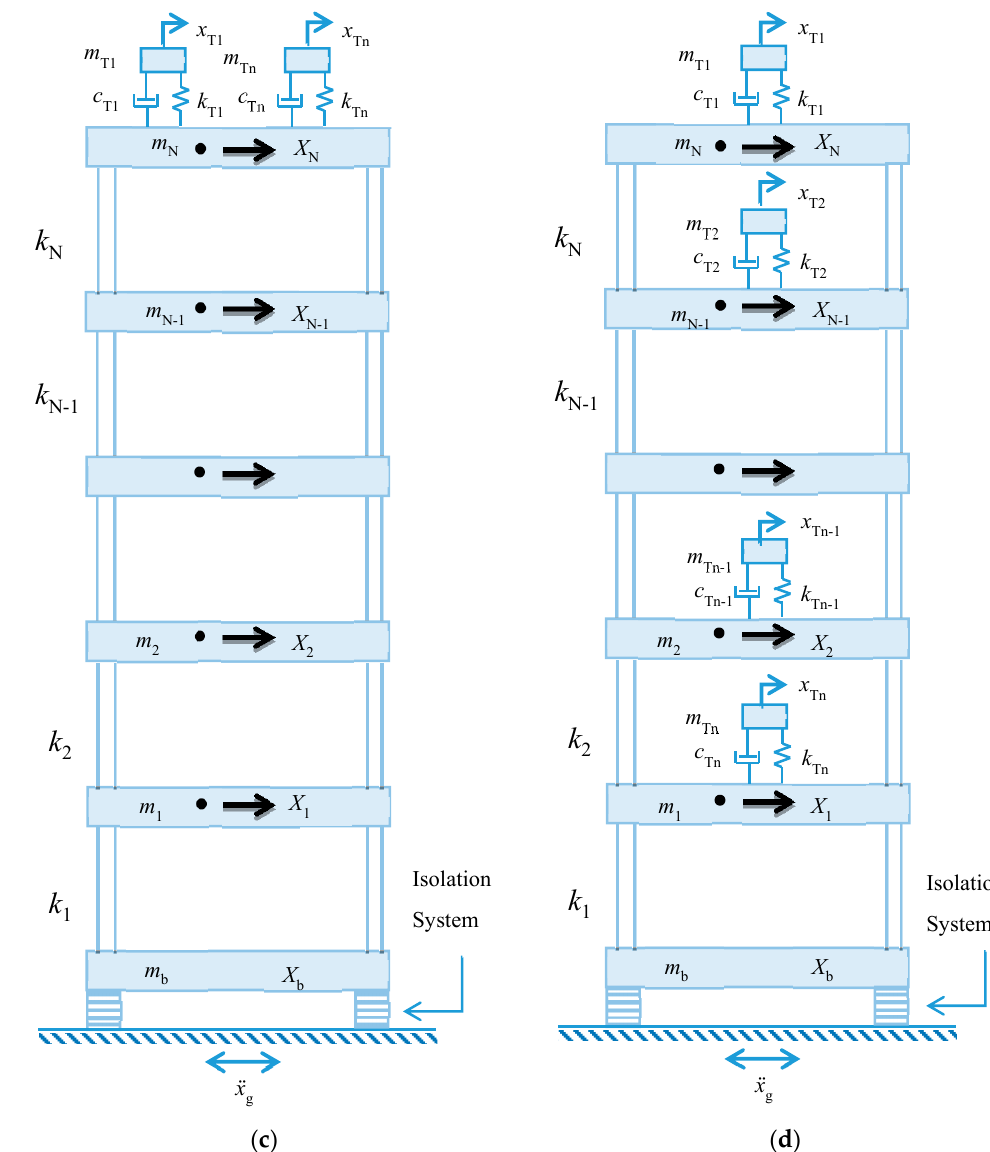
Figure 1. Schematic models of a N -story building with ( a ) base-isolation (BI), ( b ) BI + single tuned mass dampers (STMD) at top floor, ( c ) BI + multiple tuned mass dampers (MTMDs) at top floor, and ( d ) BI + distributed multiple tuned mass dampers (d-MTMDs).